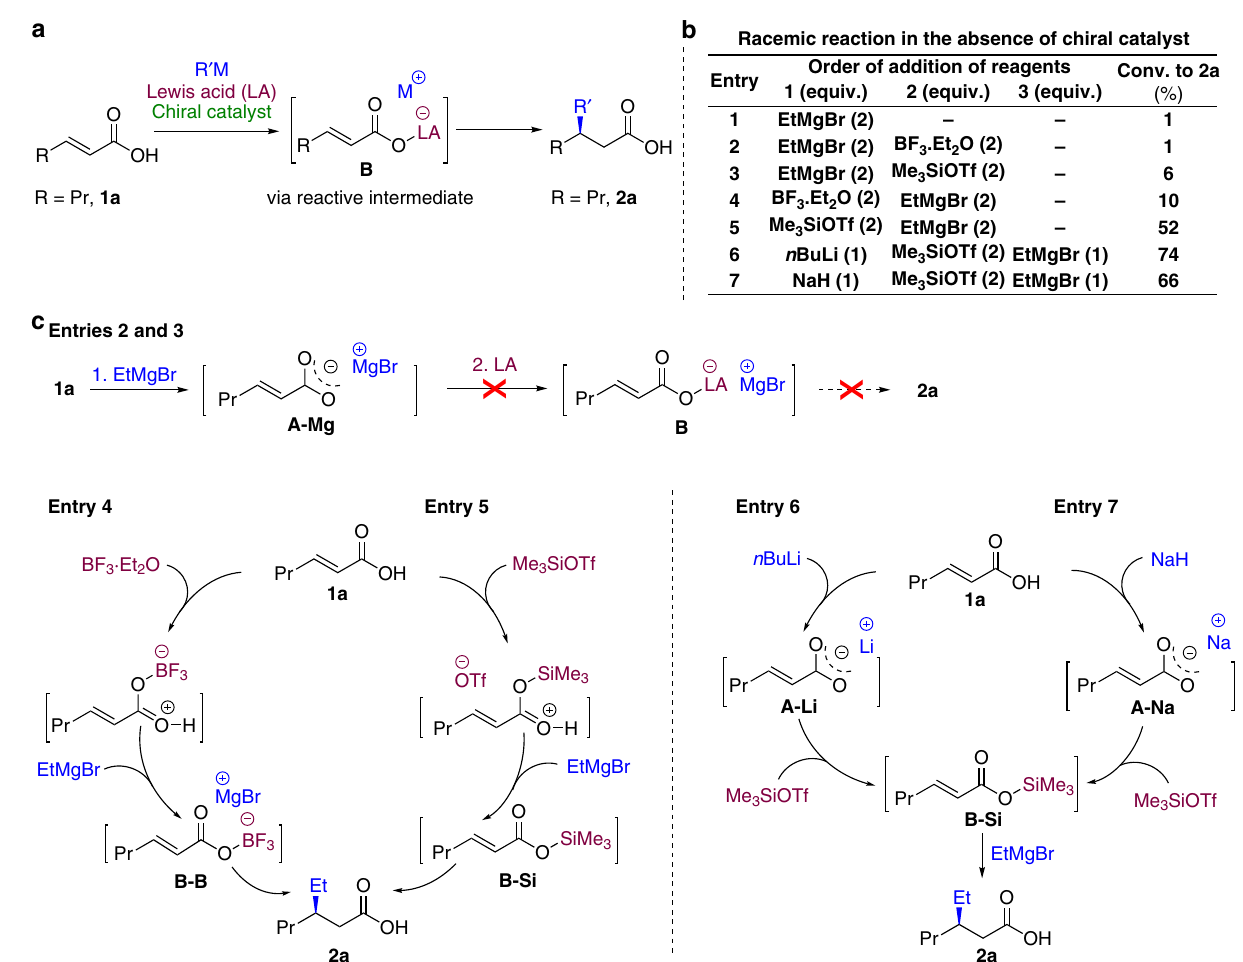
Fig. 2 Reaction development. a Our approach, based on the use of Lewis acid to promote in situ formation of a transient intermediate B that can undergo conjugate addition of organometallic reagent. b Conjugate addition of EtMgBr to the substrate 1a in the absence of chiral catalyst with varying conditions. c Rationalization of the experimental data in entries 1 – 7 obtained for conjugate addition of EtMgBr in various